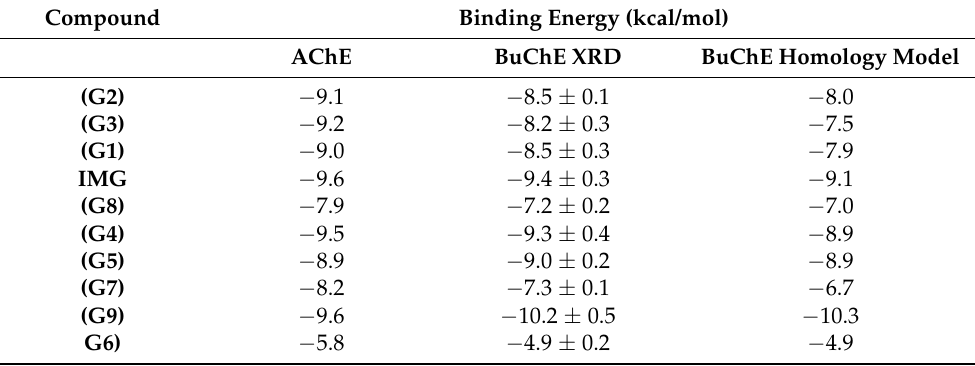
Table 4. The collection of the binding energies during docking study; the calculation results were averaged over all structures available in the same PDB record; the corresponding standard deviations are